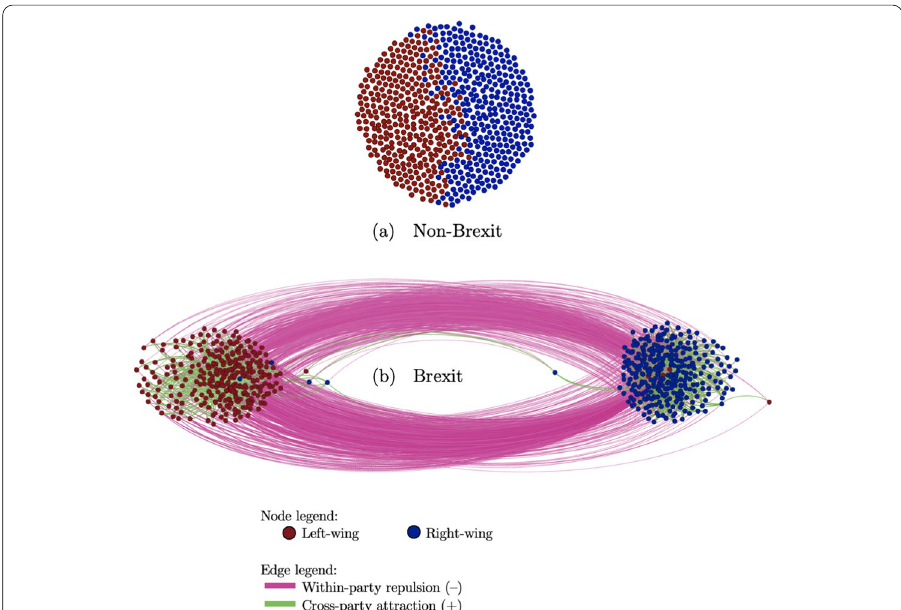
Fig. 3 Network projection of dissent and rebellion for non-Brexit (top) and Brexit divisions (bottom), for the 2 political ideology case. The absence of edges in the non-Brexit case suggest full ideological